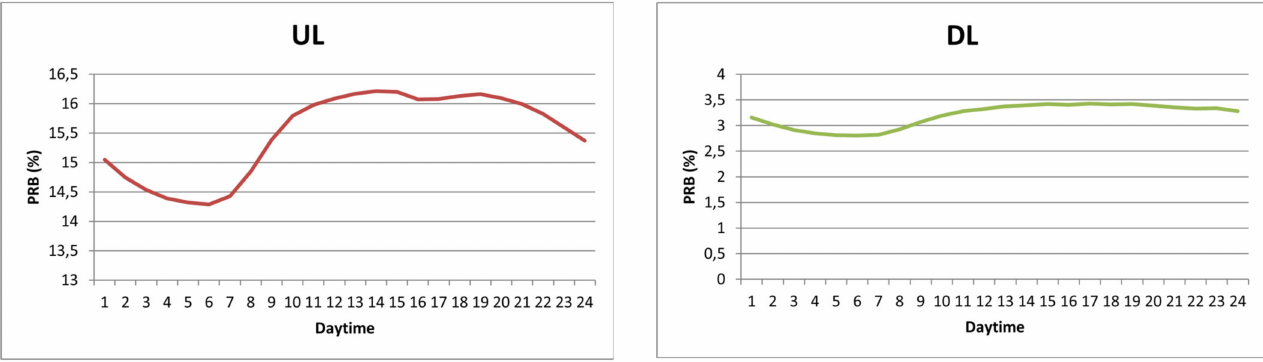
Figure 12. Daily evolution load (UL vs. DL) for 60